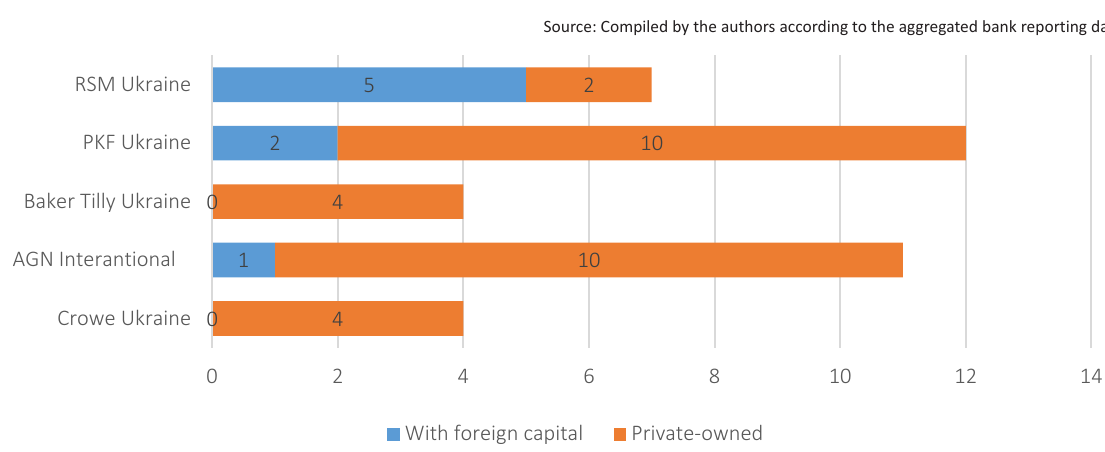
Figure 4. Audit portfolio of Ukrainian banks of B4